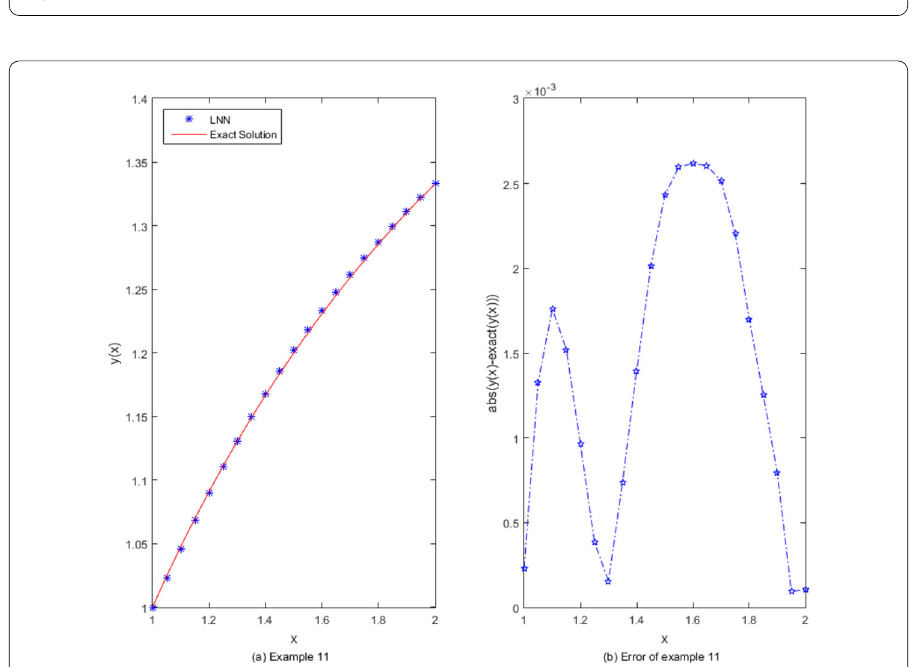
Figure 7 The absolute error for SODE